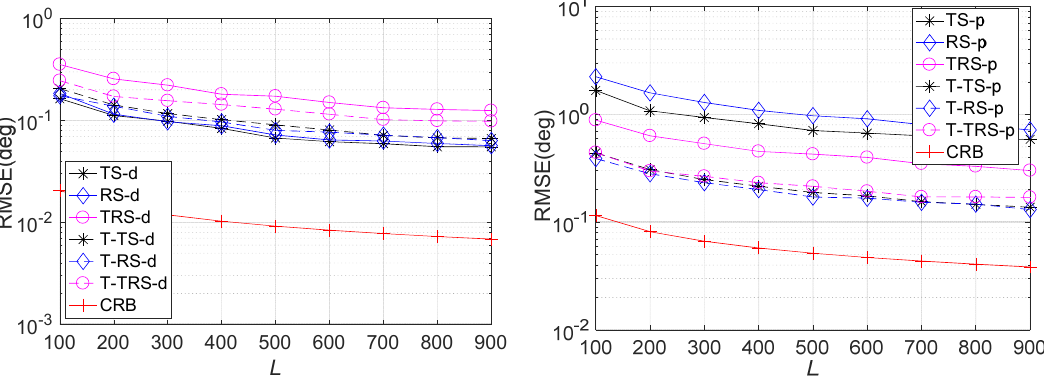
Figure 5. RMSE of parameters estimation versus L in Case (I) . Example 5. Performance comparisons versus Rx EMVS number N in case (I). Figure 6 illus- trates the average RMSE comparison and average running time (ART) comparison for completely coherent targets in Case (I) with different Rx EMVS number N, where M = 12, κ t = 2 λ , κ r = 16 λ